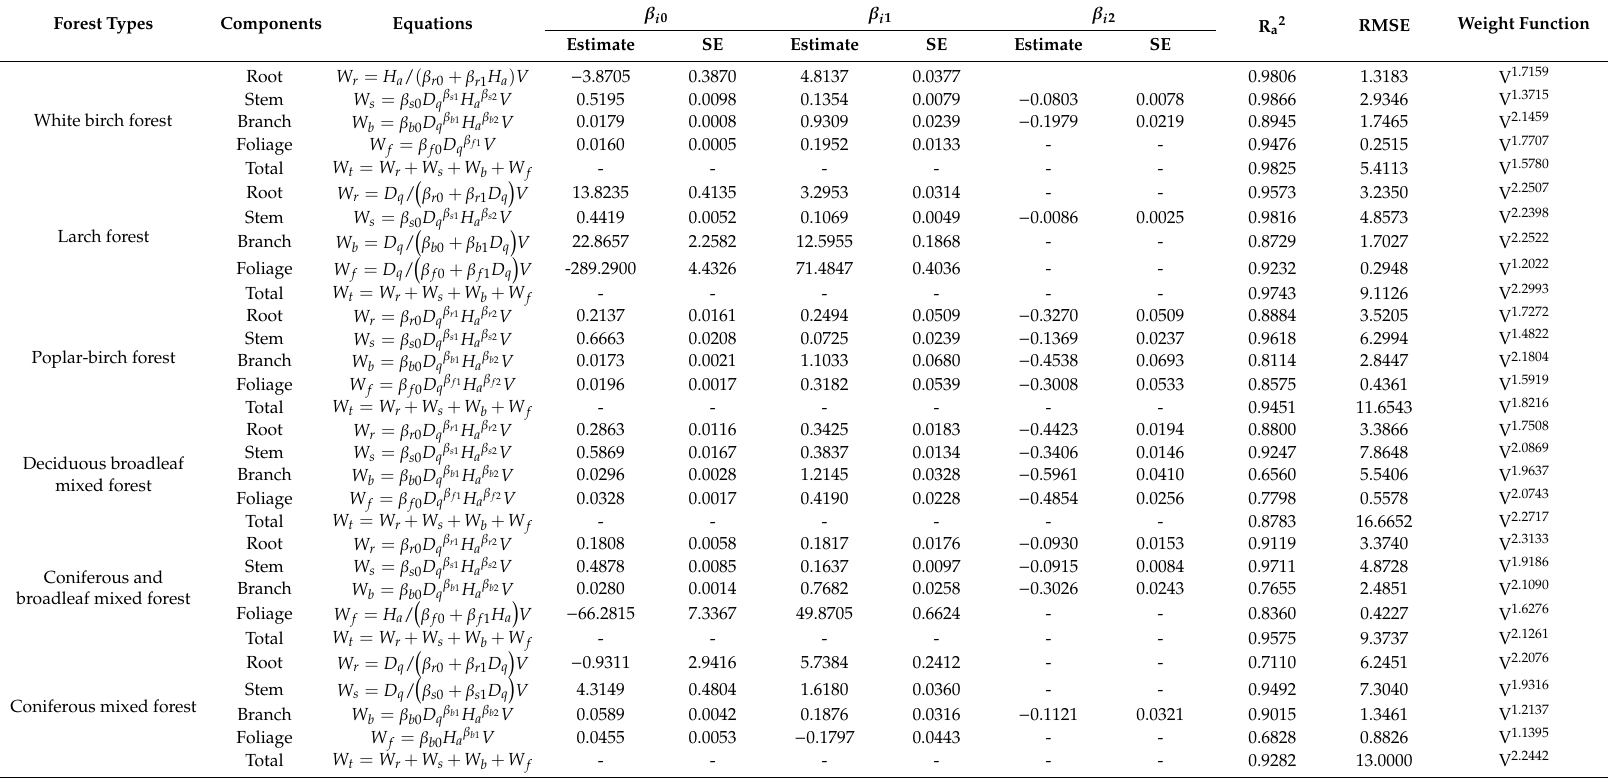
Table 5. Model coe ffi cient estimates, standard errors (SEs), model fitting statistics, and weight functions for the additive system of stand biomass equations using stand volume and BCEF (namely, M-3) for the six forest types in the Eastern Da Xing’an Mountains, Northeast